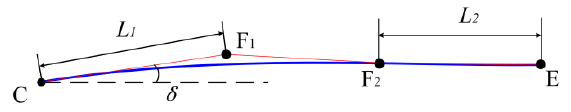
Figure 2. Schematic of the parametric design of the cowl.